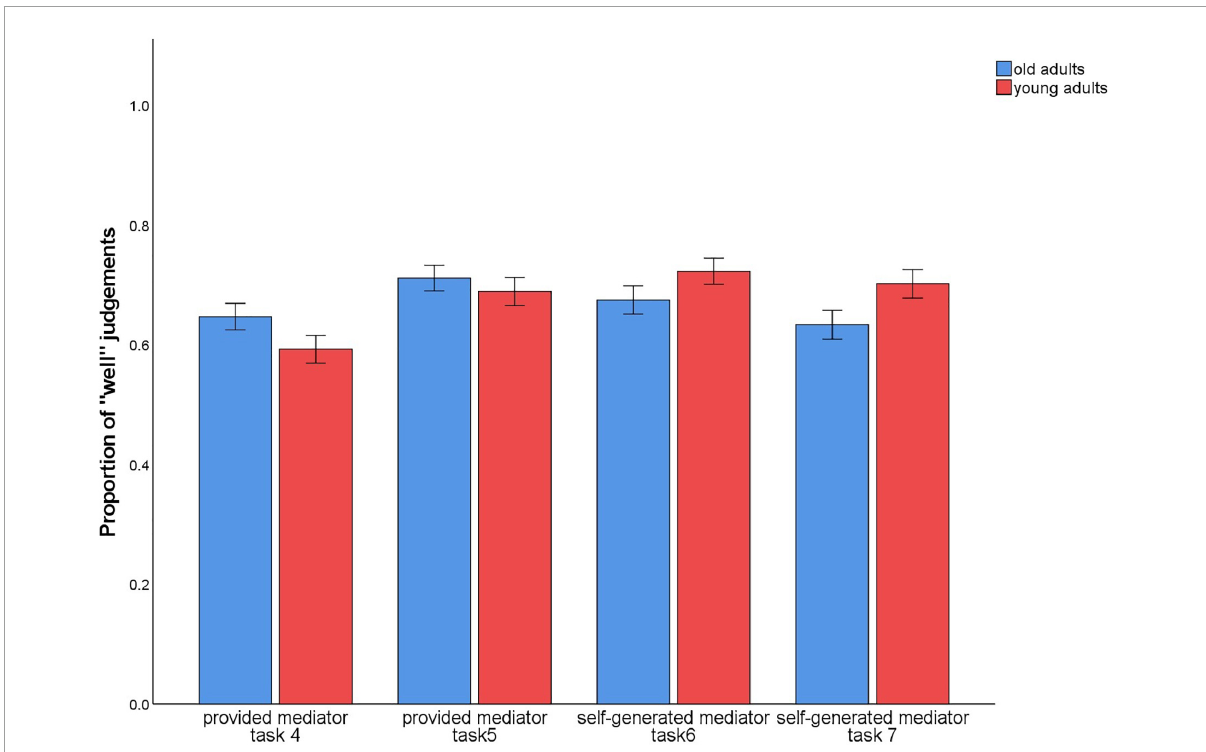
FIGURE8 Proportion of trials in which participants provided the ratings 1 (“very well”) or 2 (“rather well”) to the question of how well they could complete the sentence or imagine the interaction during encoding. Provided mediator: a sentence describing an interaction of the two words (task 4) or pictures (task 5) was given. Self-generated mediator: the sentence describing the interaction of the two words (task 6) or pictures (task 7) was to be generated by the participants themselves. After each presentation of the word or picture pairs and the given or self-generated sentence, a rating was given of how well participants could envision the sentence or imagine the interaction: 1 (“very well”); 2 (“rather well”); 3 (“rather poorly”); 4 (“very